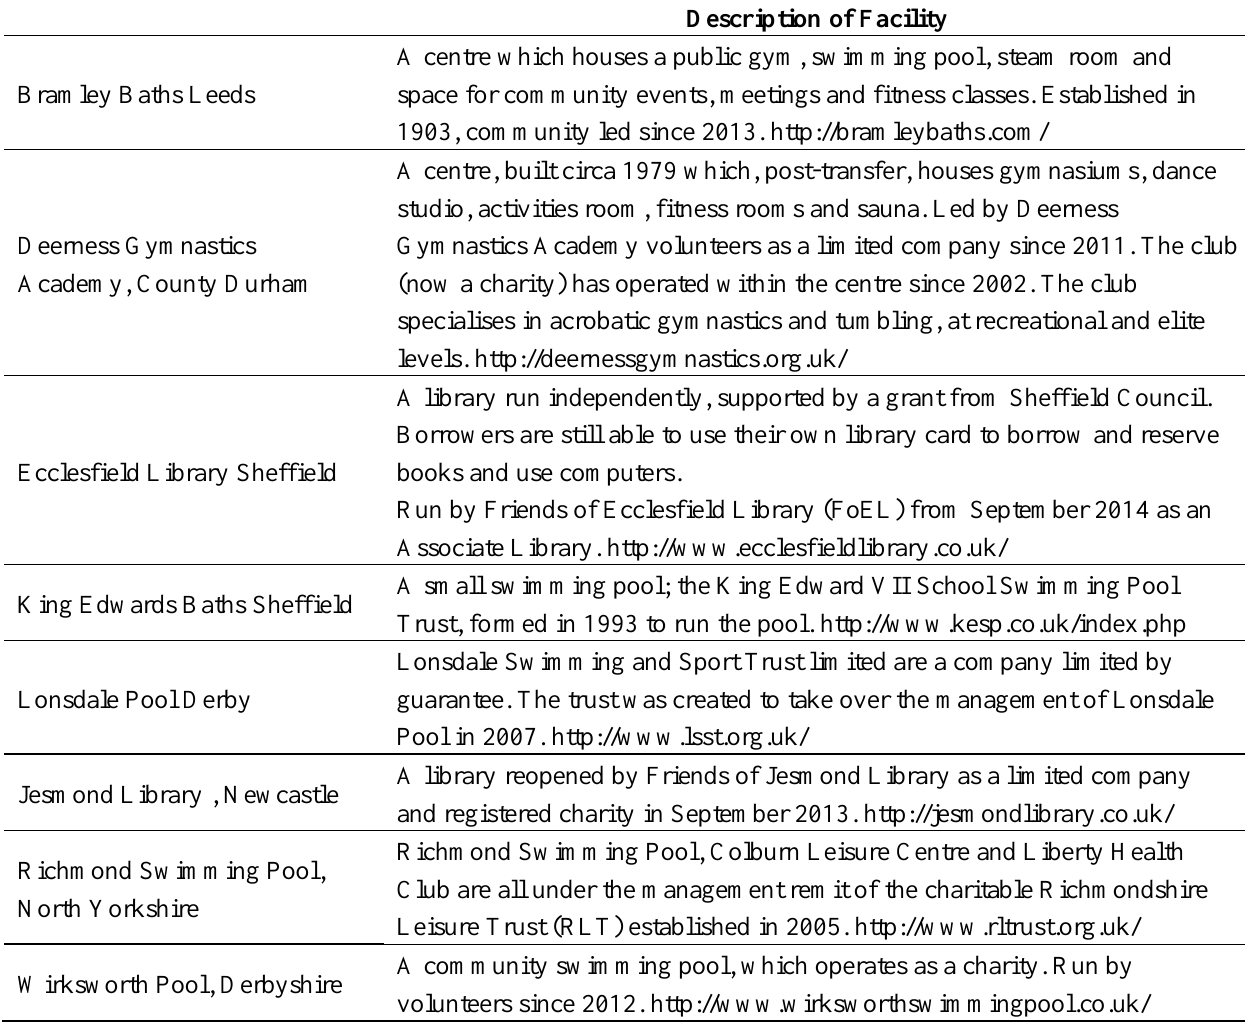
Table 2. Overview of case